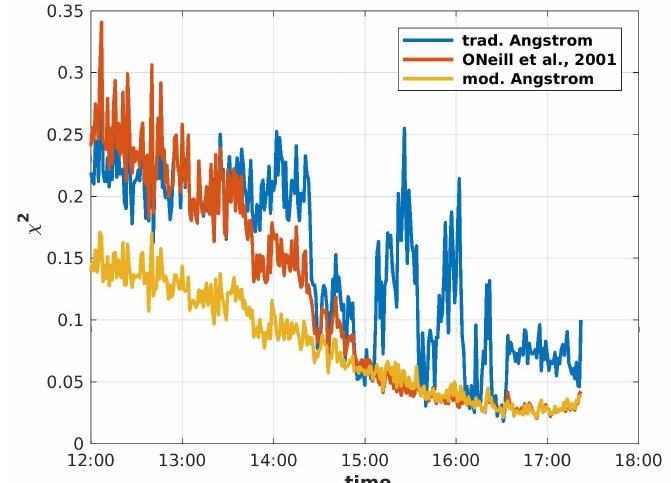
Figure 2. Comparison of the fitting accuracy χ 2 between the traditional (blue, Equation (1)), the modified Ångström law (yellow, Equation (5)), and the one that is discussed in O’Neill et al. [28] (red, Equation